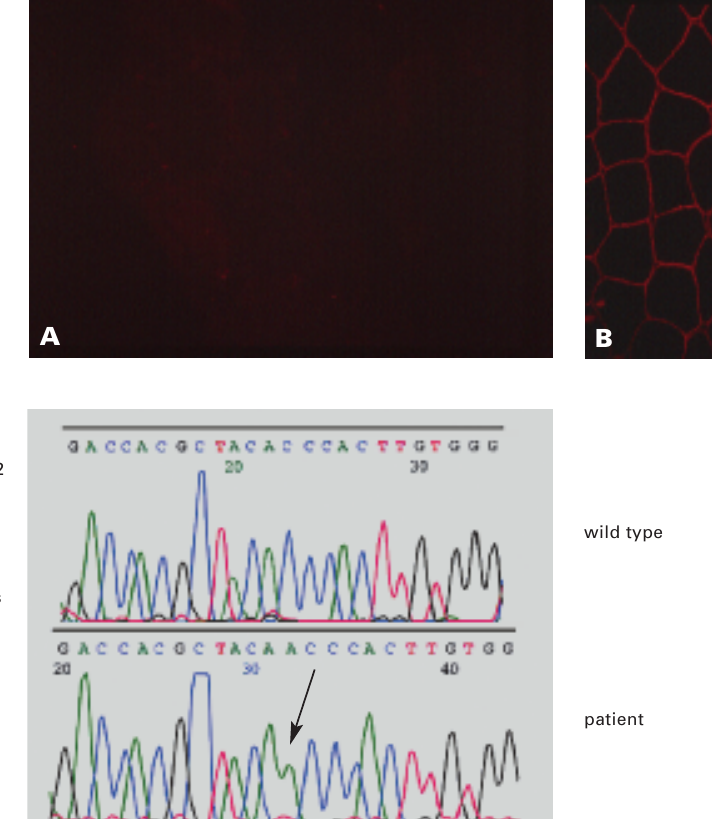
Figure 1 Immunohistochem- istry with antibodies to a -sarcoglycan shows a complete absence of the protein.